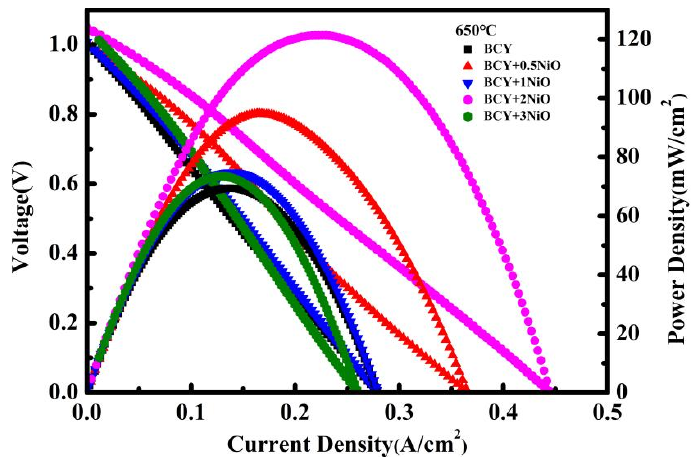
Figure 8. Current-density voltage and the corresponding current-density–power-density curves of the BCY–NiO-based SOFCs at 650 °C. Table 1. Comparison of the power density of SOFCs based on BCY electrolytes.